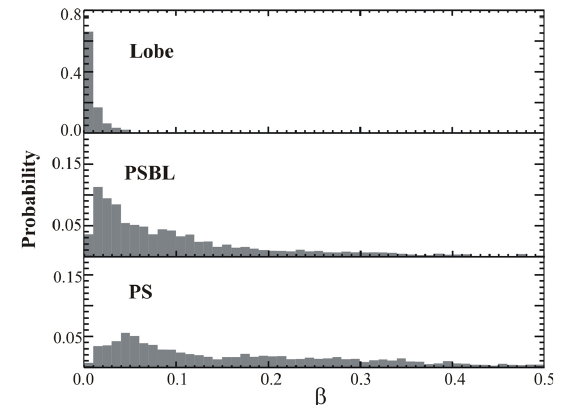
Fig. 5. Histograms of the distribution of the observation probability of the plasma β in the lobe, PSBL and the outer PS regions calcu- lated for the most frequently observed β